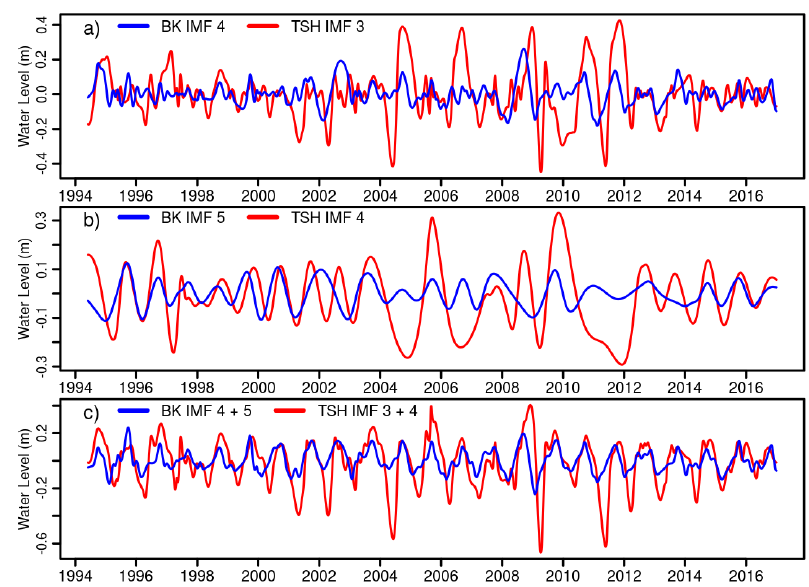
Figure 6. Low frequency IMFs at the BK and TSH stations to represent ocean-dominated and marsh-dominated hydrologic dynamics respectively. ( a ) Intra-annual modes; ( b ) annual modes; ( c ) comparison of low pass water level signals at BK and TSH constructed from the addition of the IMFs in ( a ) and ( b